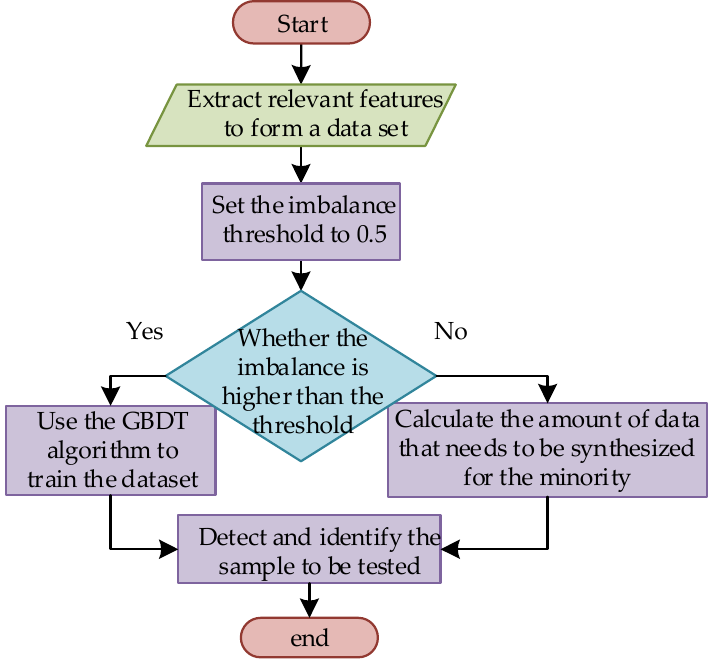
Figure 5. Flowchart of the gradient-boosting decision tree algorithm.